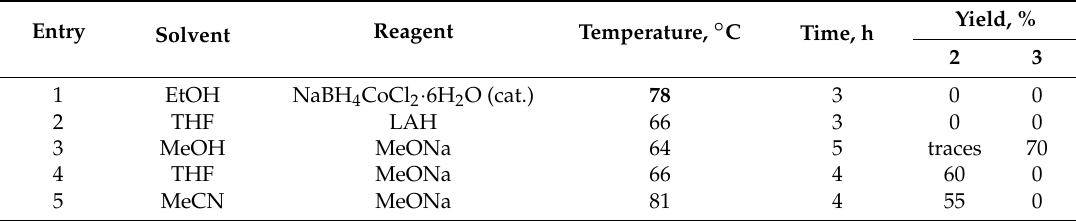
Table 1. Reaction of 4,7-dibromo[1,2,5]thiadiazolo[3,4- d ]pyridazine 1 with reducing agents.